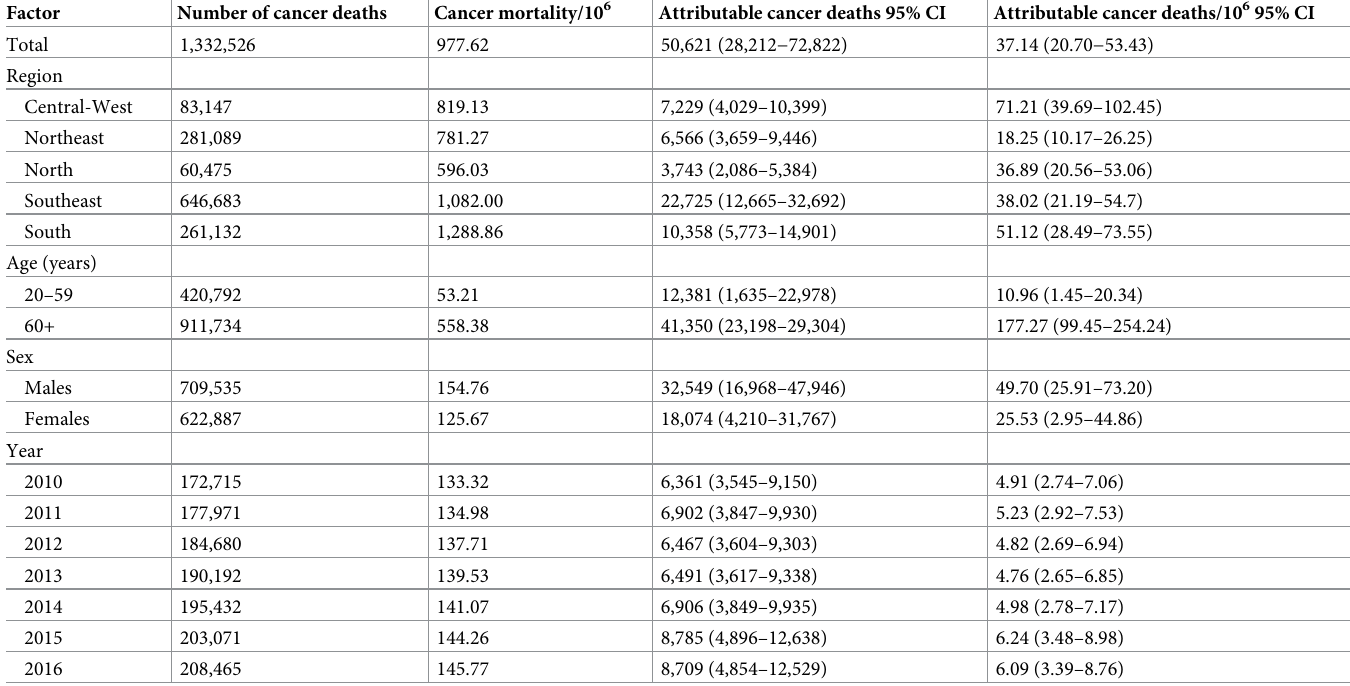
Table 2. Cancer deaths and attributable cancer deaths associated with 2-year average wildfire-related PM 2.5 exposure by region, age, sex, and year during 2010– 2016 AU : InTable 2 : Pleaseindicate ð e : g :; inthecolumnheadsortablefootnote Þ whatthevaluesinparenthesesinthelasttwocolumnsrepresent : 95 % CIs ? ranges ? . Factor Number of cancer